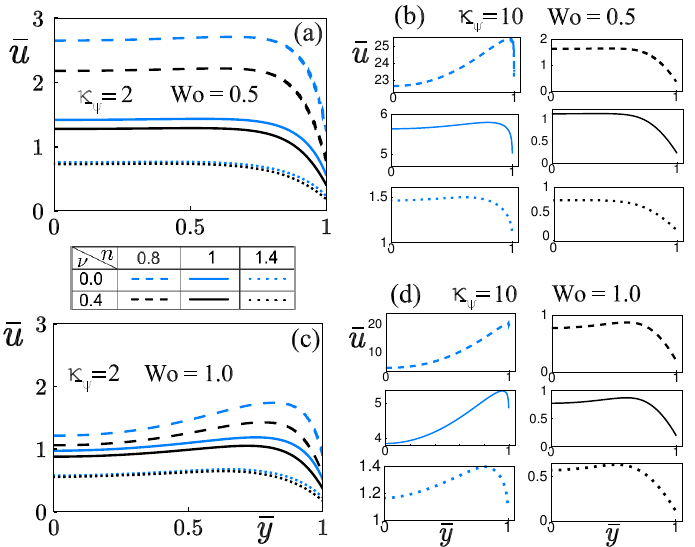
Figure 6. The velocity profiles are shown for shear-thinning and shear-thickening fluids. ( a ): κ ψ = 2, and Wo = 0.5. ( b ): κ ψ = 10, and Wo = 0.5. ( c ): κ ψ = 2, and Wo = 1.0. ( d ): κ ψ = 10, and Wo =